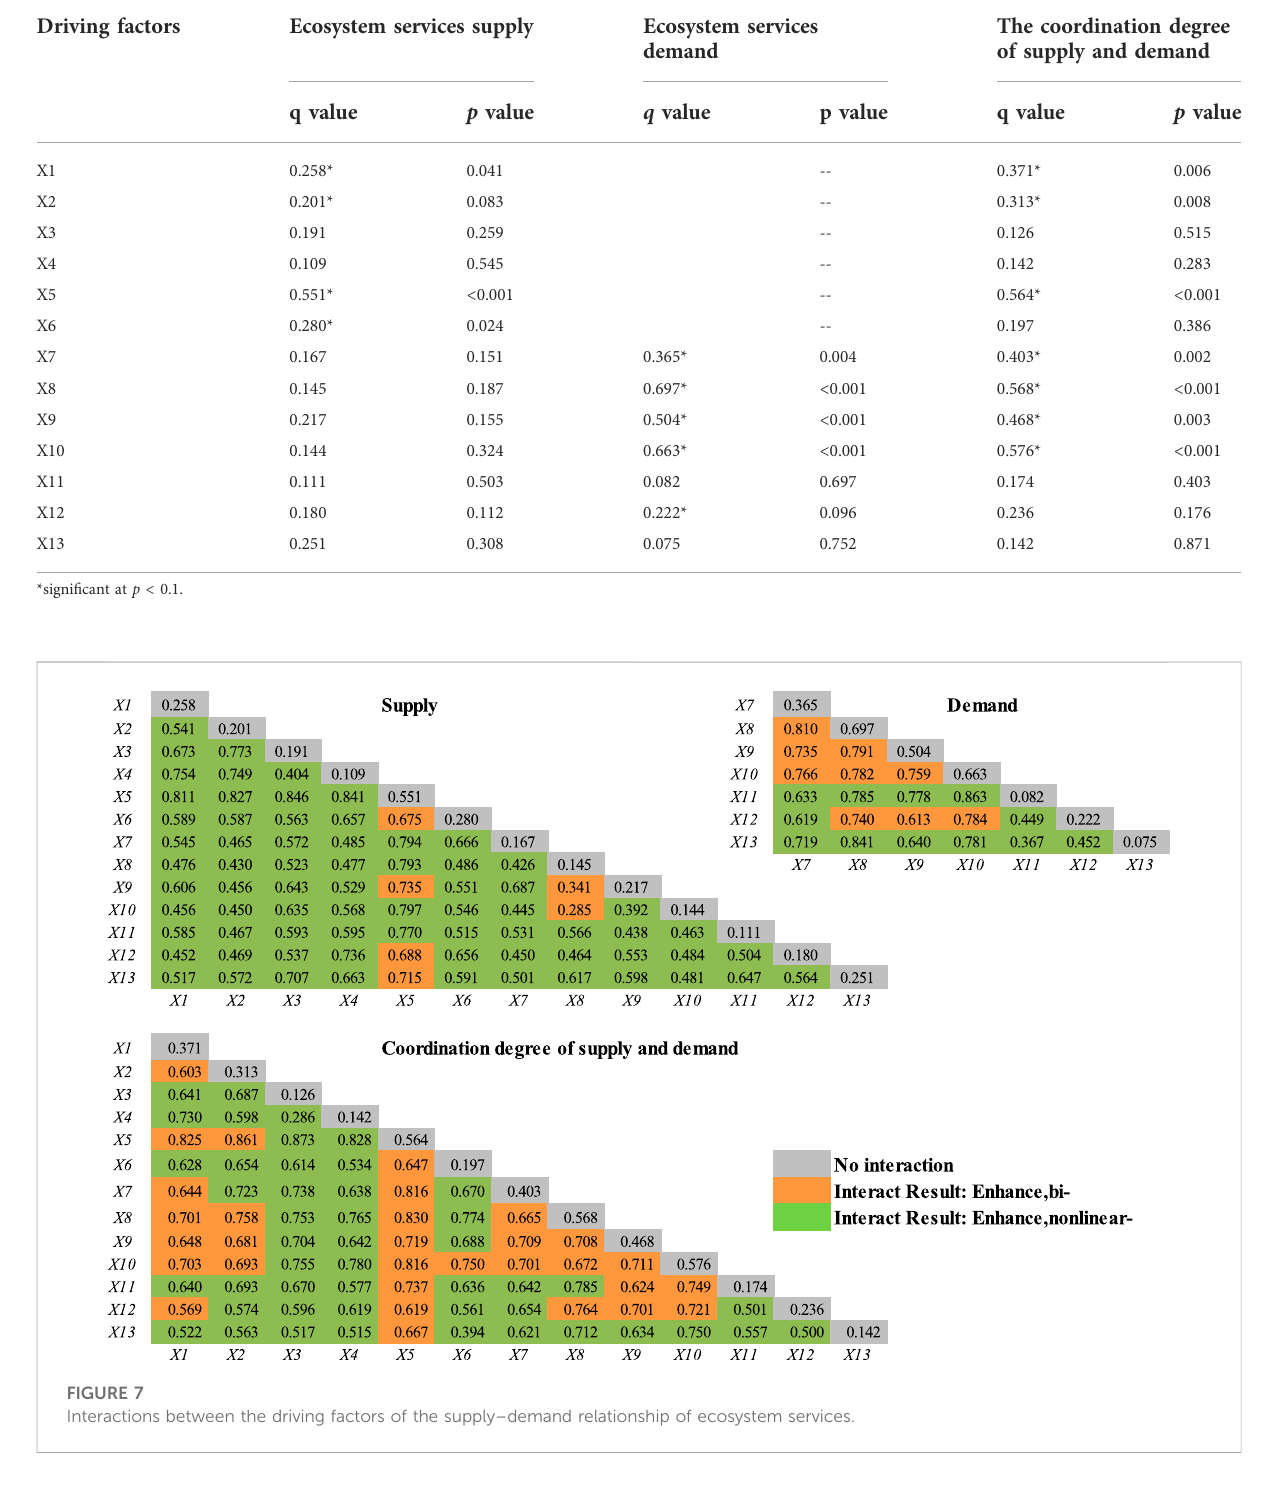
TABLE 6 Detection results of driving factors of ecosystem service supply and demand in Jiangsu Province.